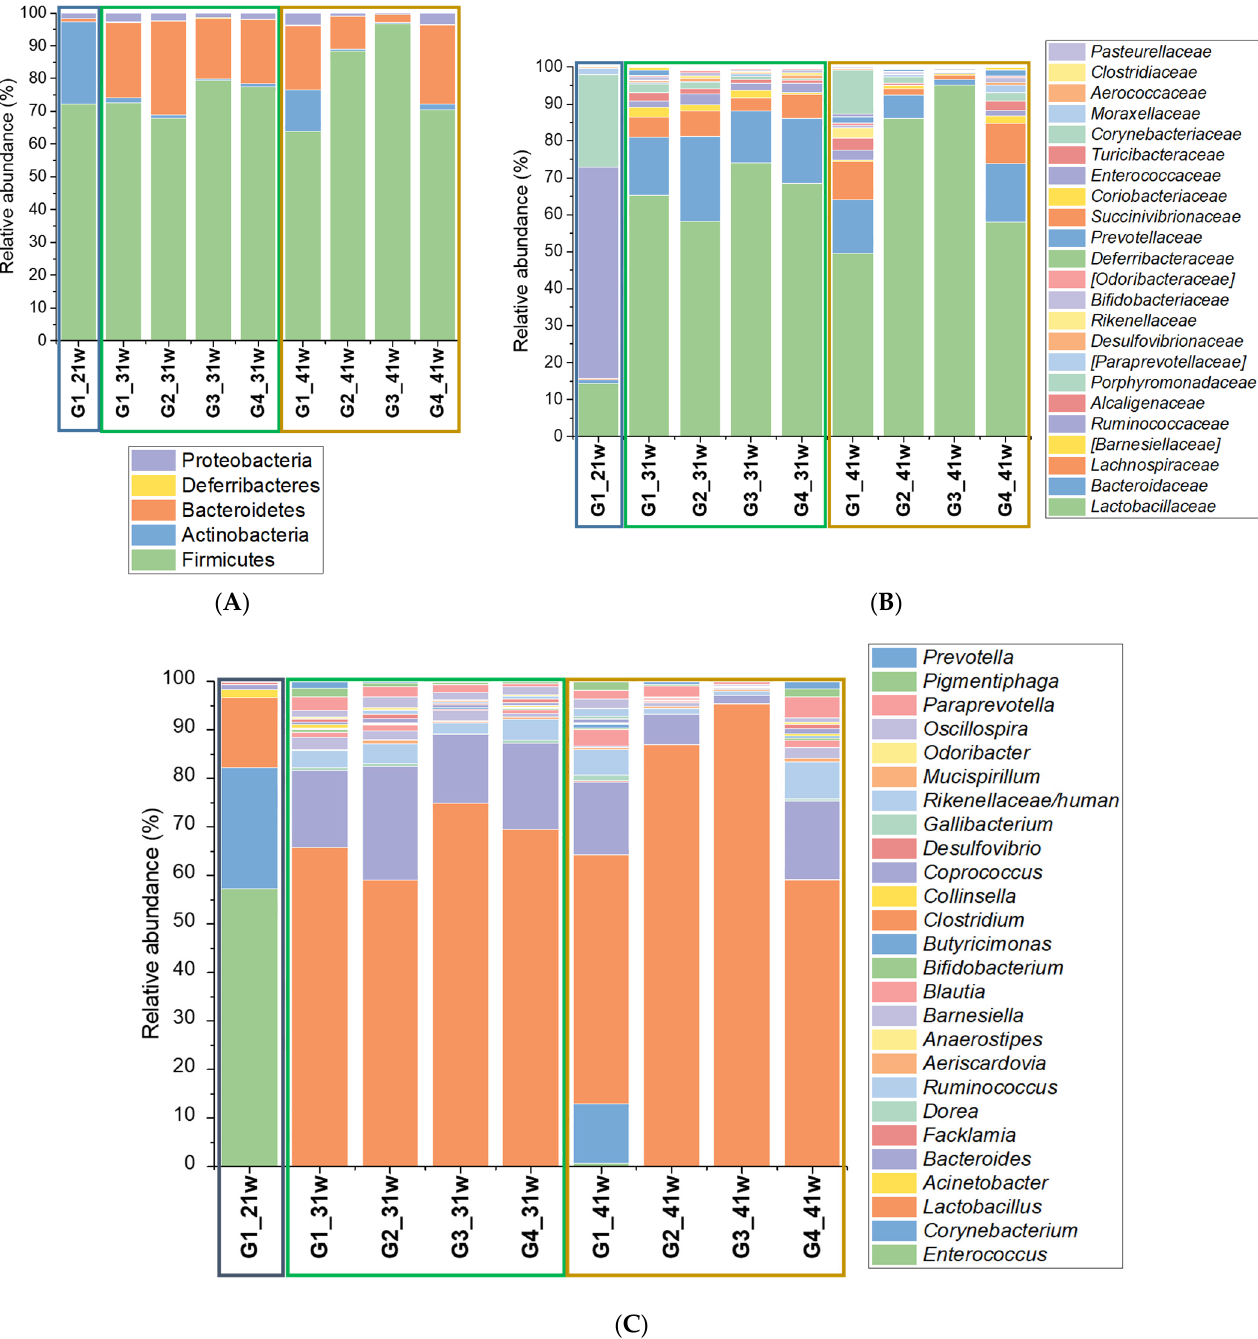
Figure 1. Bacterial communities associated with fecal samples obtained from laying hens supple- mented and unsupplemented with an Allium-based phytobiotic, and challenged or unchallenged against Salmonella Pullorum. Bars represent the relative abundance at ( A ) Phylum , ( B ) Family, and ( C ) Genus level. G1: Control group; G2: Salmonella phytobiotic-supplemented unchallenged hens; G3: Salmonella -phytobiotic-supplemented challenged hens; G4: Salmonella -challenged hens. Samples number of hens for each treatment was